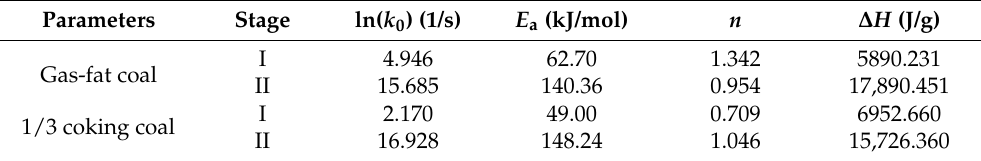
Table 4. Fitting parameters of multiple linear regressions for gas-fat coal and 1/3 coking coal.